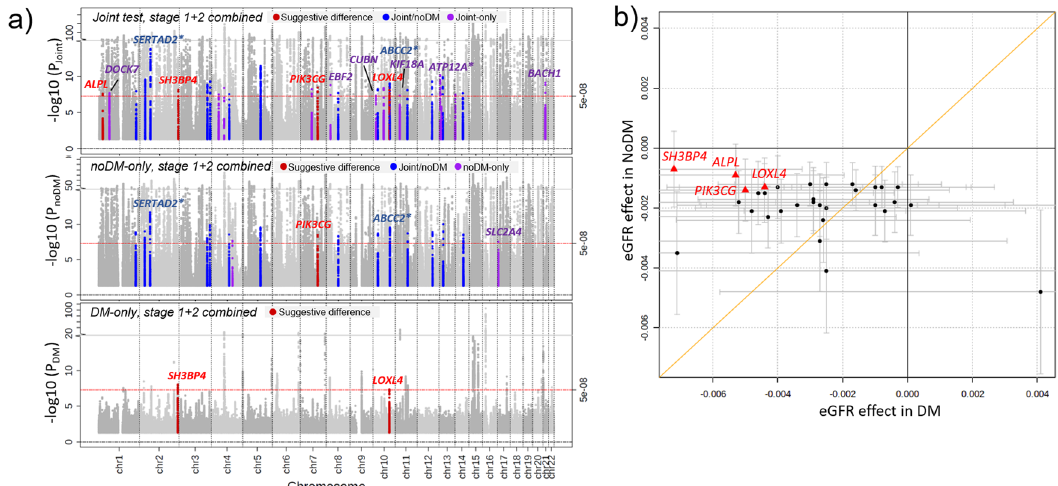
Fig. 3 Accounting for potential DM-/noDM-differences identi fi ed 32 novel eGFR loci. We searched for novel loci associated with eGFR allowing for DM-/noDM-difference using the joint test or DM-/noDM-strati fi ed tests approaches in combined stage 1 + 2 ( n DM = 178,691; total n noDM = 1,296,113). We found 32 novel genome-wide signi fi cant eGFR loci (P < 5 × 10 − 8 , >500 kB distant of known eGFR loci compared to previous work 16,20 ): 30 by joint, 17 by noDM-only and 2 by DM-only test. a Shown are P -values for eGFR based on joint, noDM-only, and DM-only test over chromosomal position. Highlighted in red are loci with suggestive DM/noDM-difference ( P Diff < 0.05/34; corrected for 34 independent variants across 32 loci), blue for loci identi fi ed by joint and noDM-only test (15 loci), and purple for loci that were only identi fi ed by joint test (upper panel) or noDM-only test (middle panel). Loci were annotated by nearest genes if P Diff < 0.10 or if they were also identi fi ed by the discovery + replication design (the latter also indicated by asterix, Table 2). b Shown is a comparison of DM-/noDM-speci fi c eGFR-effect sizes for the 32 novel eGFR locus lead variants. Highlighted in red are the locus names of loci with suggestive DM/noDM-difference ( P Diff < 0.05/34; corrected for 34 independent variants across 32 loci). Effect sizes are aligned to the